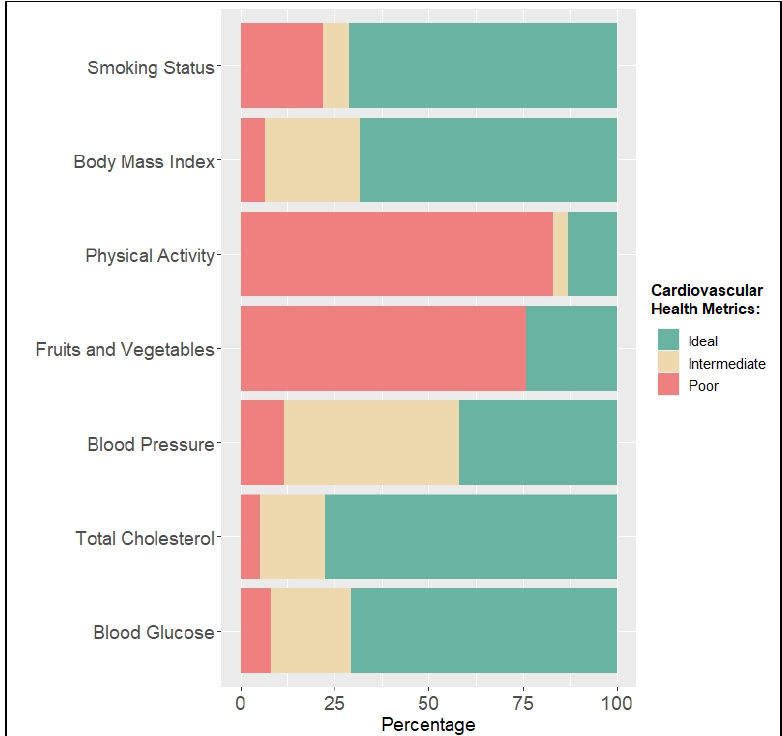
Figure 1. Prevalence of poor, intermediate, and ICH metrics for each of the seven cardiovascular health metrics.